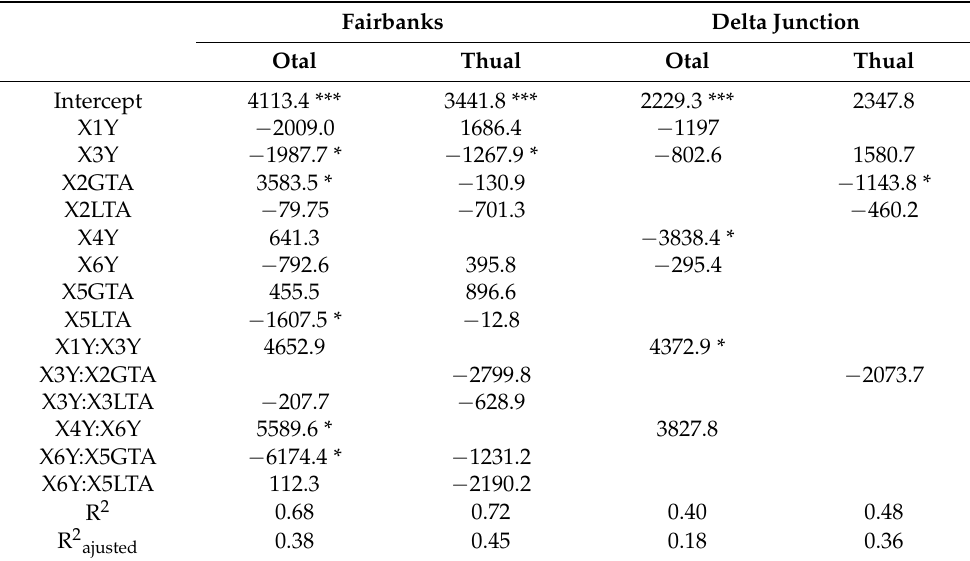
Table 6. The coefficients, R 2 , R 2 ajusted of models of yields of ‘Otal’ and ‘Thual’ in Fairbanks and Delta Junction. The independent variables are categorical climatic parameters at 10 days BH and AH based on Equation (7). Fairbanks Delta Junction Otal Thual Otal Thual Intercept 4113.4 *** 3441.8 *** 2229.3 *** 2347.8 X1Y − 2009.0 1686.4 − 1197 − 1987.7 * − 1267.9 * − 802.6